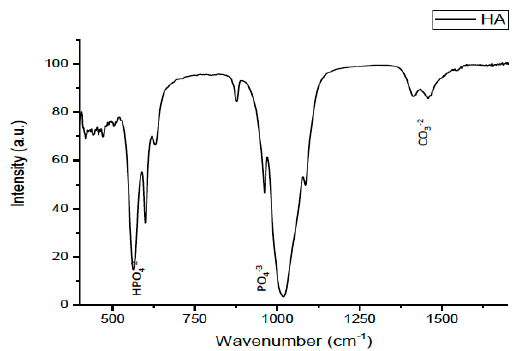
Figure 3. Typical Raman spectra of the HA showing chemical groups identified by Micro-Raman analysis that could be identified as phosphate ( υ 1 PO 4 ~960 cm − 1 ) and carbonate (CO 3 ~1070 cm − 1 ). Coatings 2020 , 10 , x FOR PEER REVIEW